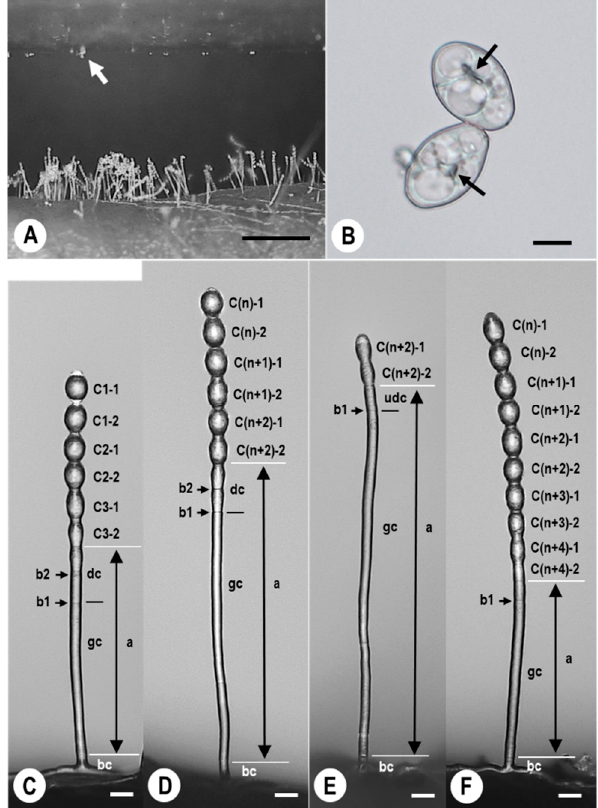
Figure 1. Micrographs of conidia collected from a single KSP-7N powdery mildew colony to the insulator film with an electrostatic technique ( A , B ), and conidiophores observed during electrostatic spore collection under greenhouse conditions ( C – E ) or in darkness ( F ). ( A ) Digital micrograph revealing the collection of progeny conidia dispersed from a single 10-day-old KSP-7N powdery mildew colony on a strawberry leaf to an insulator film. The film (arrowed) charged at 1.0 nC was placed 900 µ m from the top of the KSP-7N conidiophore. The scale bar is 600 µ m. ( B ) Light micrograph revealing conidia attracted on the film. Oil and fibrosin bodies (arrows) were observed in single KSP-7N conidia. The scale bar is 10 µ m. ( C – F ) Digital micrographs revealing conidiophores possessing six conidial cells (C1-1 to C3-2) in full-length chains, a divided conidia cell (dc), a generative cell (gc), and a basal cell (bc) on hyphae in KSP-7N colonies ( C ), six conidial cells (C(n) − 1 to C(n + 2) − 2), dc, gc, and bc ( D ), immature conidial cells (C(n + 2) − 1, C(n + 2) − 2), an undivided conidial cell (udc), gc, and bc ( E ) under greenhouse conditions, and ten conidial cells (C(n + 1) − 1 to C(n + 4) − 2), dc, gc, and bc ( F ) in darkness. Conidial cells were produced by repeatedly elongating the gc and dividing twice via septation (black right-pointing b1 and b2 arrows). The double-pointed arrow (a) indicates the length of an elongated gc. Once the septum between the apical conidium and the next conidial cell in ( C , D ) had fully constricted, KSP-7N conidiophores released progeny conidia. The scale bars are 20 μ m.